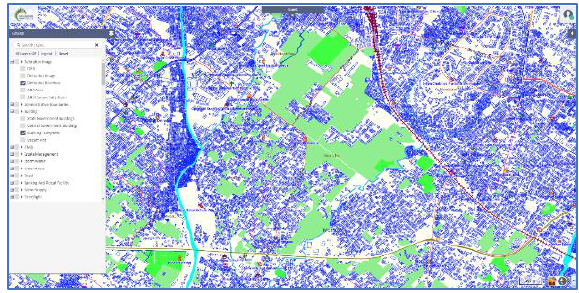
Figure_5: Building Footprints from Satellite Data